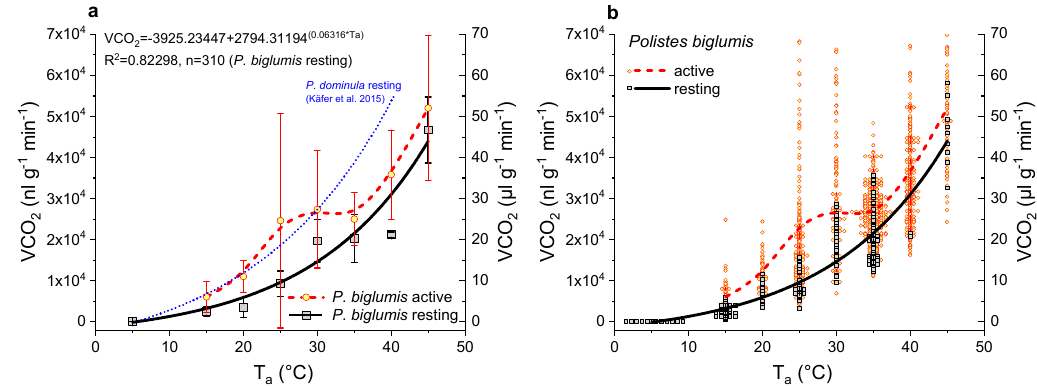
Figure 4. ( a ) Means ± SD and ( b ) single values of CO 2 production rate in dependence on ambient temperature (T a ) of active (red) and resting (black) wasps ( Polistes biglumis ). The dotted line (blue) represents the CO 2 production rate of Polistes dominula from Käfer et al. [5].